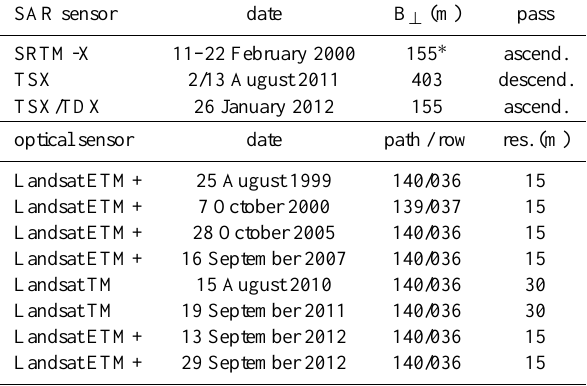
Table 1. Overview of satellite data and date of data acquisition. Per- pendicular baseline, B ⊥ and pass direction are given for SAR acqui- sitions (Fig. 1). For Landsat data path and row number is given next to the spatial